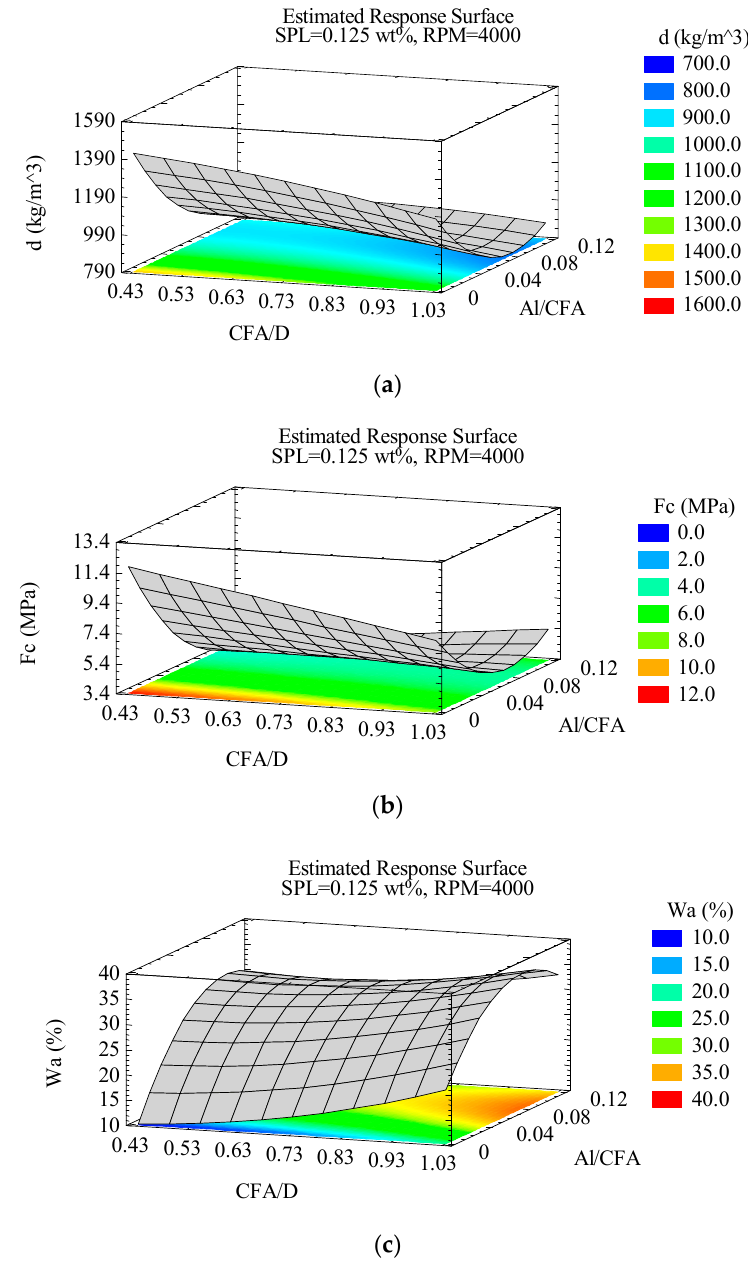
Figure 10. Plots of response surfaces of ( a ) density; ( b ) compressive strength; ( c ) water absorption, as function of the design factors CFA/D and Al/CFA. SPL and RPM are kept constant at their middle levels.